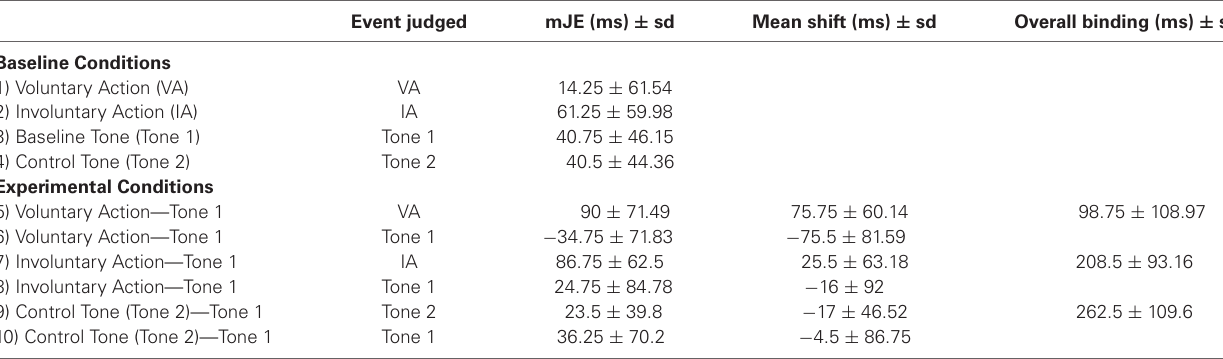
Table 2 | mJEs, perceptual shifts and overall binding in young adults (Experiment I)